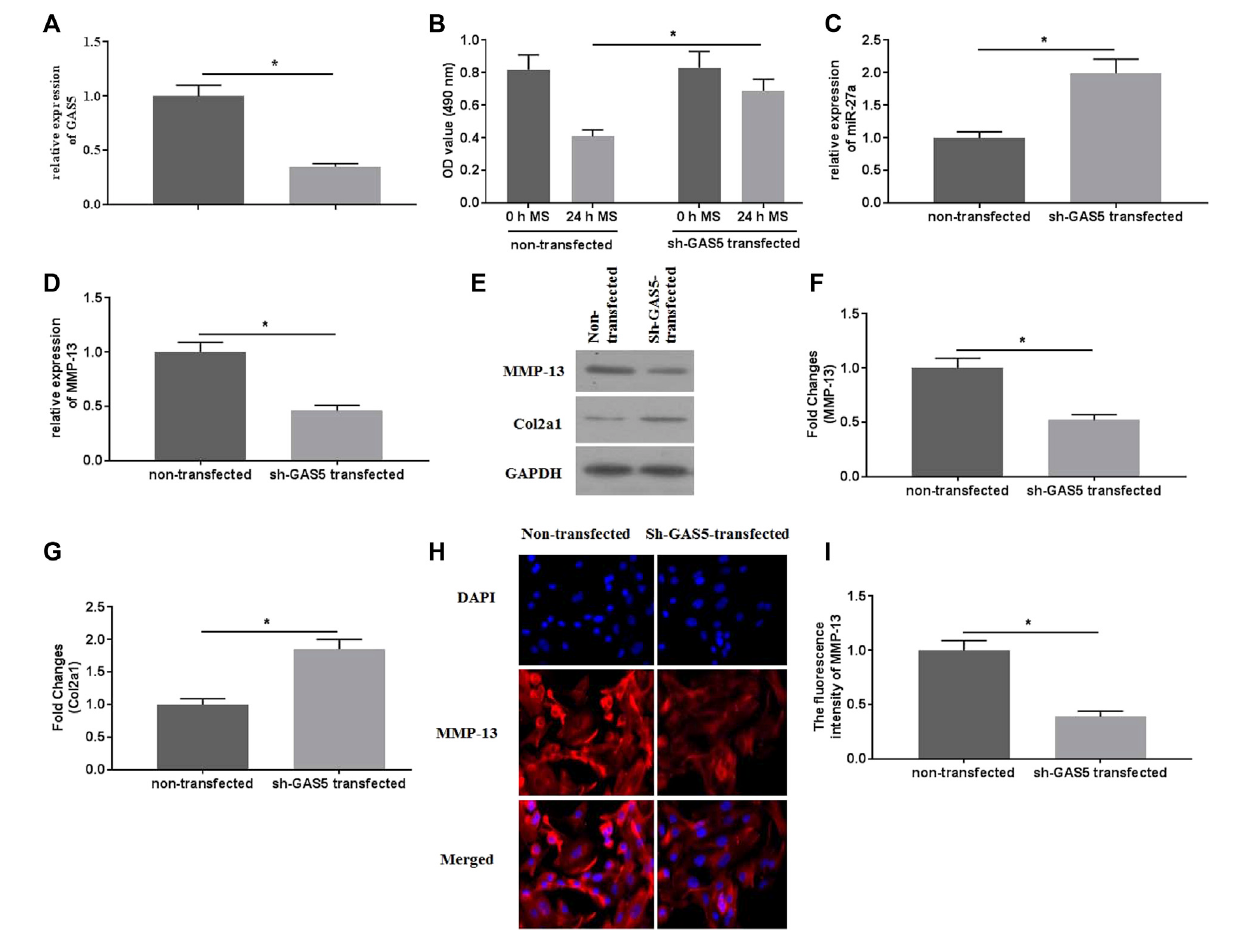
FIGURE 3 | The effects of suppressed GAS5 expression on mechanical stimulation-induced MMP-13 expression were investigated. (A) The expression of GAS5 was detected by qRT-PCR in sh-GAS5-transfected chondrocytes. (B) The cell viability was determined by CCK-8 assays. (C) The expression of miR-27a was determinedbyqRT-PCR.ThemRNA (D) expressionofMMP-13wasdeterminedbyqRT-PCR,andtheproteinexpressionofMMP-13 (E-F) andCol2a1 (E and G) were detected bywestern blotting assays. (H) The immuno fl uorescence intensity of MMP-13 was detected. (I) The calculation of fl uorescence activity of MMP-13. * p < 0.05 and ** p < 0.01.